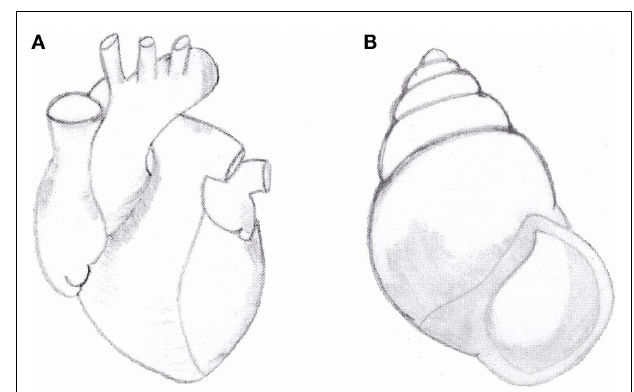
FIGURE 2 | (A) Anatomical aspect of normal heart with situs solitus. Note the right-handed spiral pattern of outflow tract and great arteries. (B) Right-handed shell of the snail Amphidromus perversus rufocinctus .